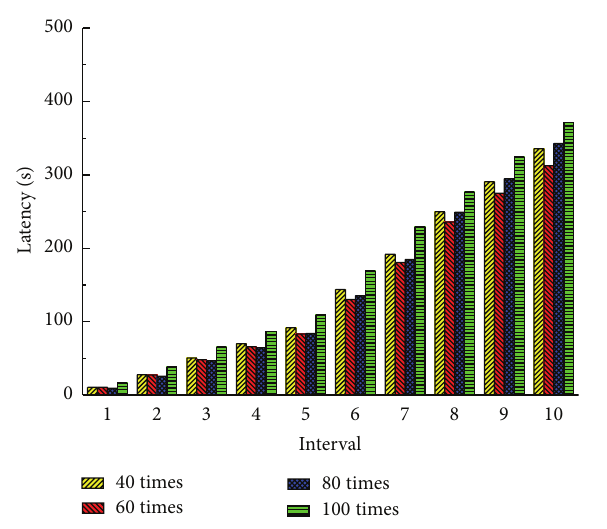
Figure 4: Total latency of all services (20 nodes).